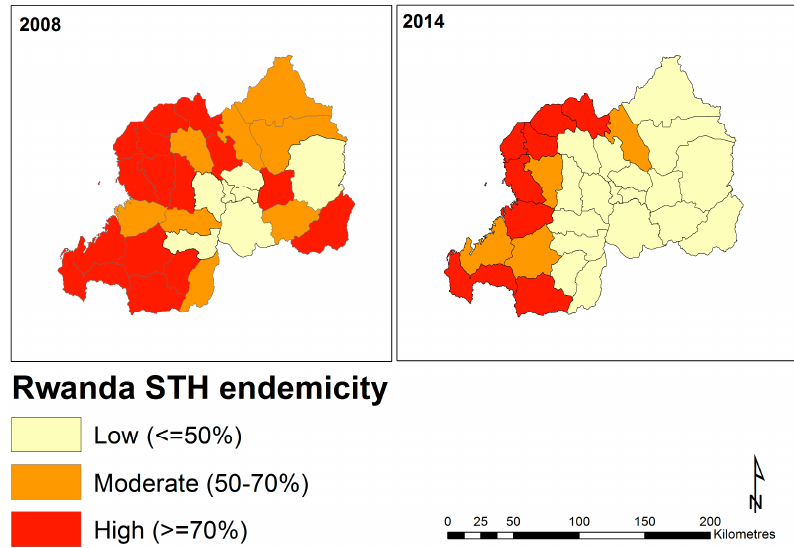
Figure 4. Chloropleth maps of estimated soil-transmitted (STH) helminth endemicity, represented as proportions of surveyed individuals found to be infected with at least one STH parasite ( A. lumbricoides , T. trichiura , and hookworm), in Rwanda across two survey periods. This figure was produced in ArcMap 10.4 (ESRI, Redlands, CA) using a shapefile representing Rwanda’s current administrative units (obtained from the data warehouse DIVA GIS).